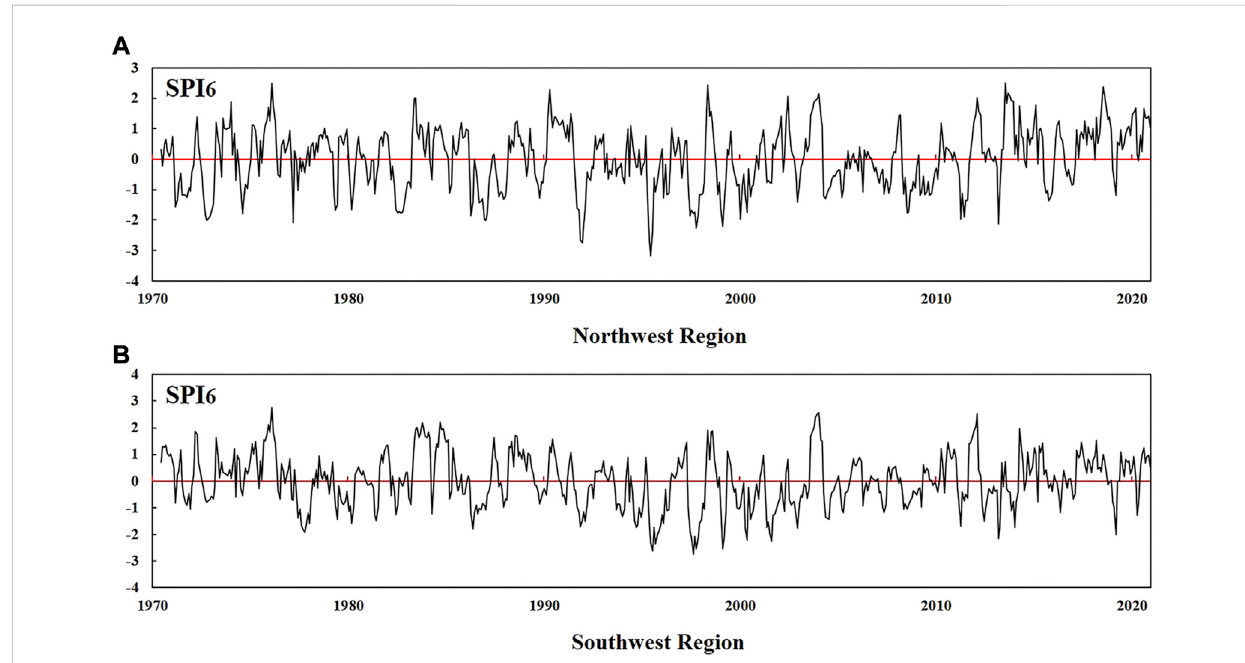
FIGURE 6 Evolution of SPI series at a 6-month timescale obtained from the two regional precipitation series. (A) Northwest Region. (B) Southwest Region.